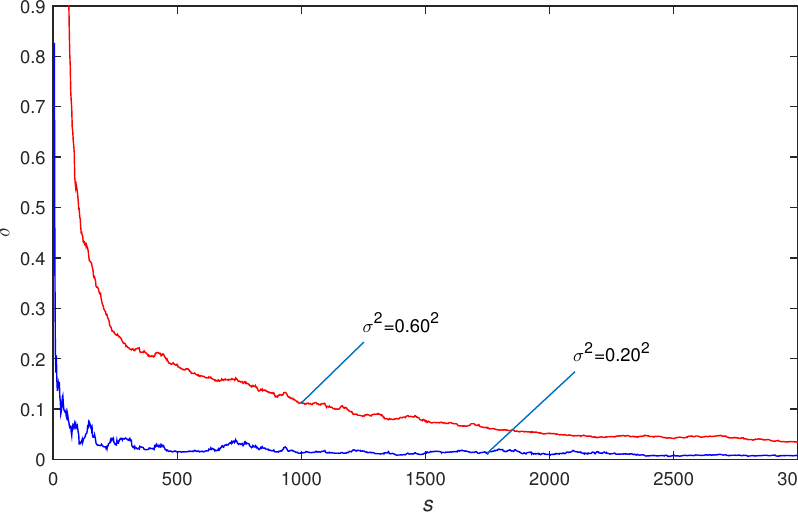
Figure 4. The PC-RGELS estimation errors δ versus s with different σ 2